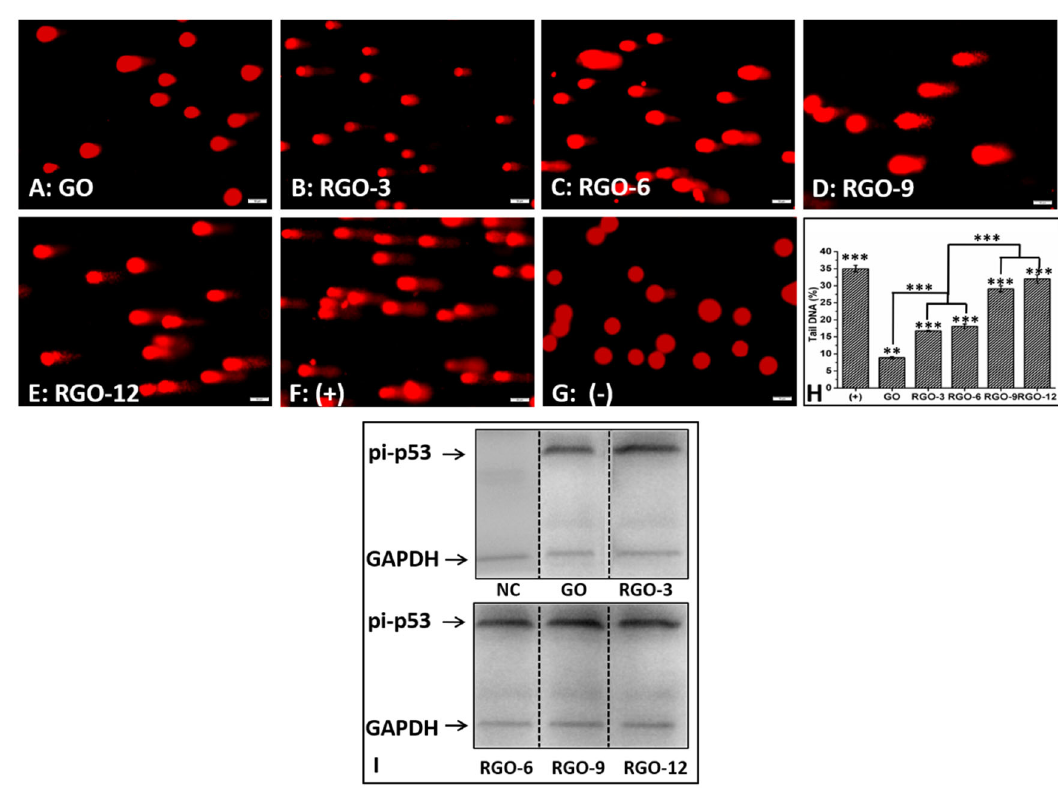
Fig. 5 Fluorescence images of ARPE-19 cells during the Comet test after exposed to A GO, B RGO-3, C RGO-6, D RGO-9, E RGO-12, F the positive control, and G the negative control. Scale bar = 50 μ m. H The percentages of tail DNA detected. I Western blot images of pi-p53 expression after exposure of ARPE-19 cells to GO or